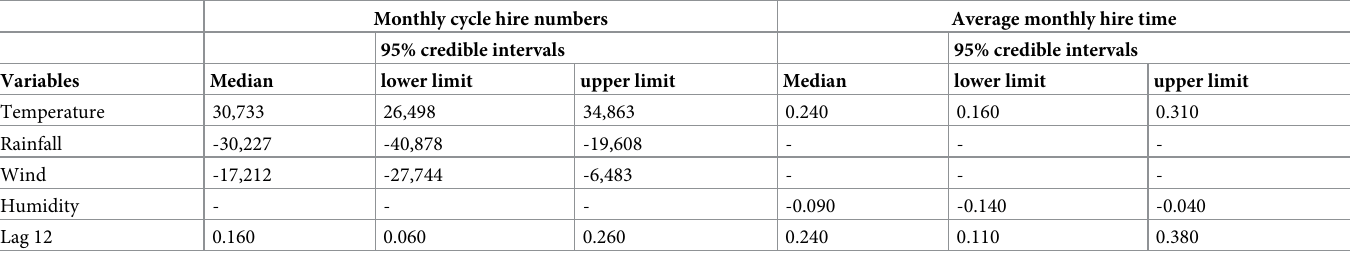
Table 3. Posterior summary of the regression